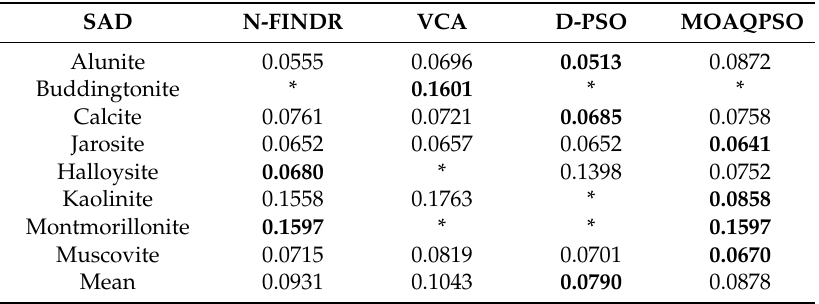
Table 4. Comparison between the SAD values of N-FINDR, VCA, D-PSO, and MOAQPSO. * means that material cannot be extracted.